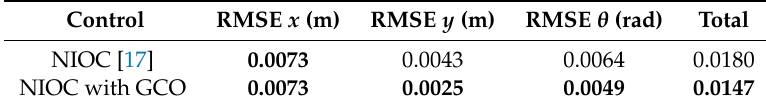
Table 2. Root Mean Squared Error (RMSE) in states for second simulation. Bold values highlight the best result.